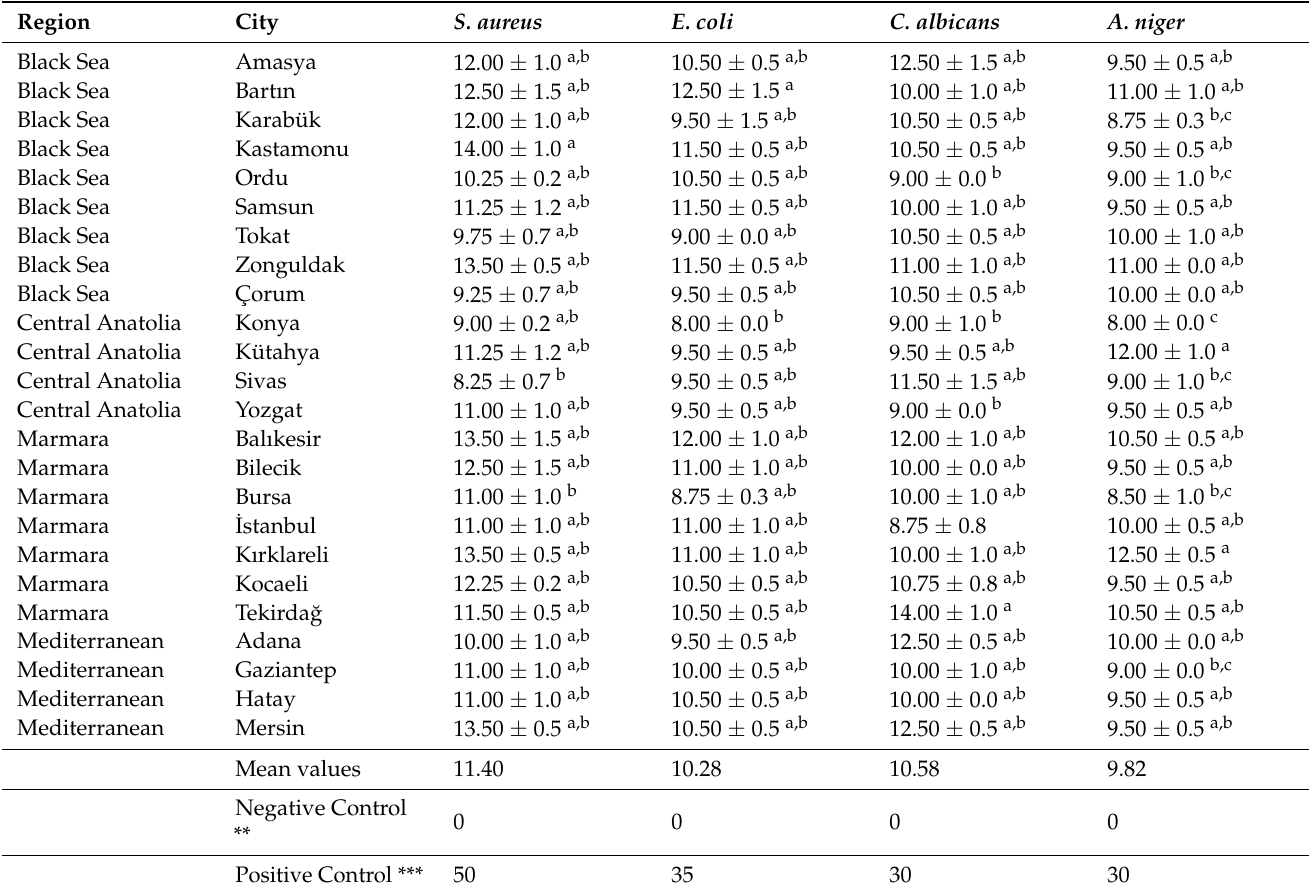
Table 4. Antimicrobial activity results of ethanolic extracts of Anatolian propolis (data are expressed as millimeter (mm) inhibition